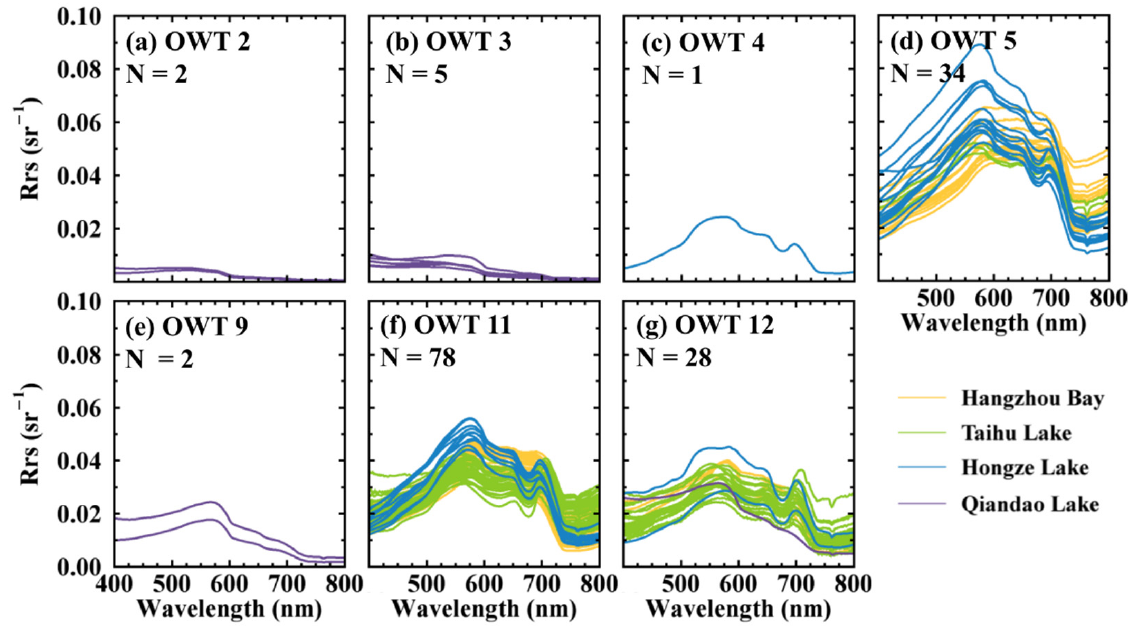
Figure 2. In situ measured hyperspectral data that were categorized in OWTs.